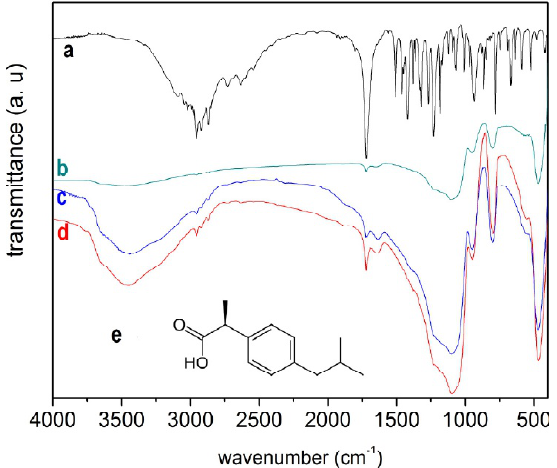
Fig. 2. Infrared spectra of (a) ibuprofen molecule, (b) SiO -Mag-IBU (1:24), (c) SiO 2 (d) SiO -Mag-IBU (1:8) and (e) Chemical structure 2 of the ibuprofen molecule.